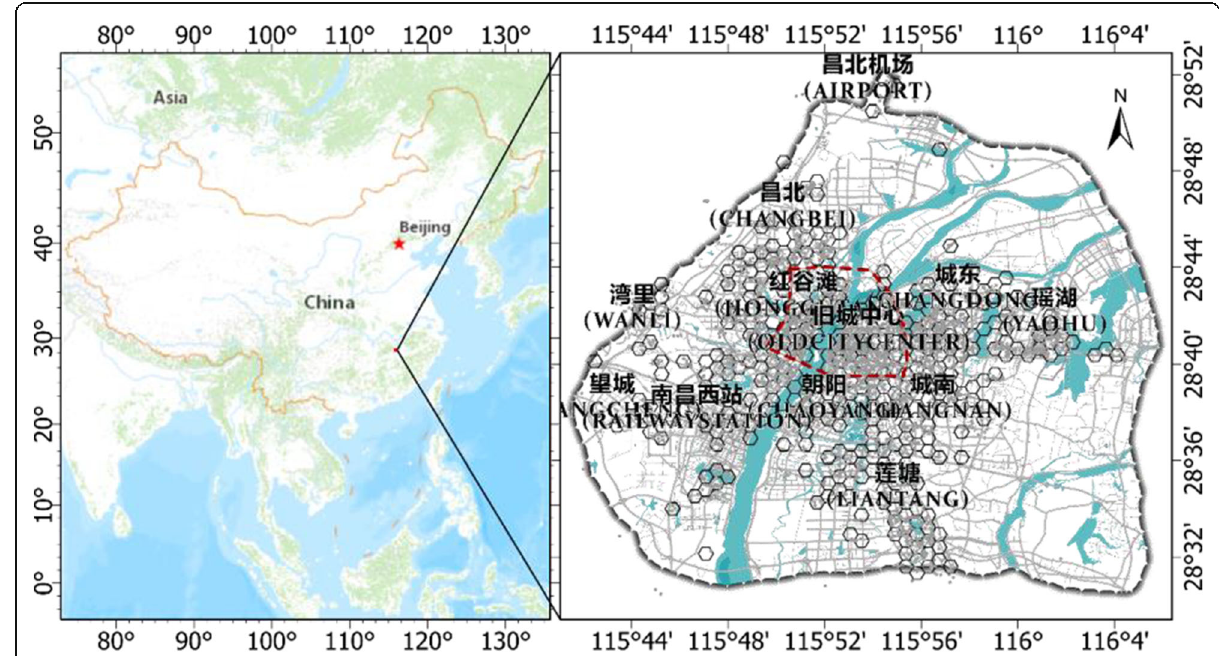
Fig. 1 Study area: Nanchang city. The red line indicates the first ring in Nanchang. Each gray point represents a Weibo check-in